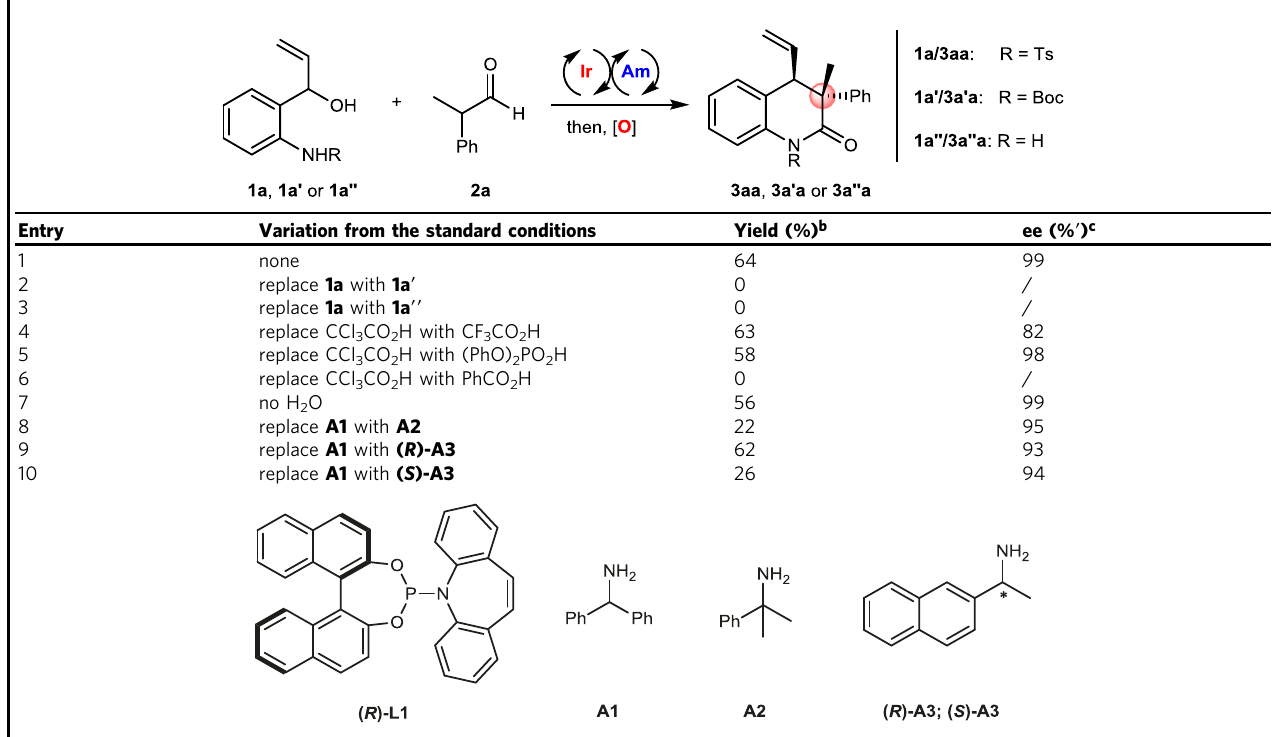
Table 1 Optimization of the reaction conditions for the [4 + 2] cycloaddition of vinyl aminoalcohols and aldehydes a